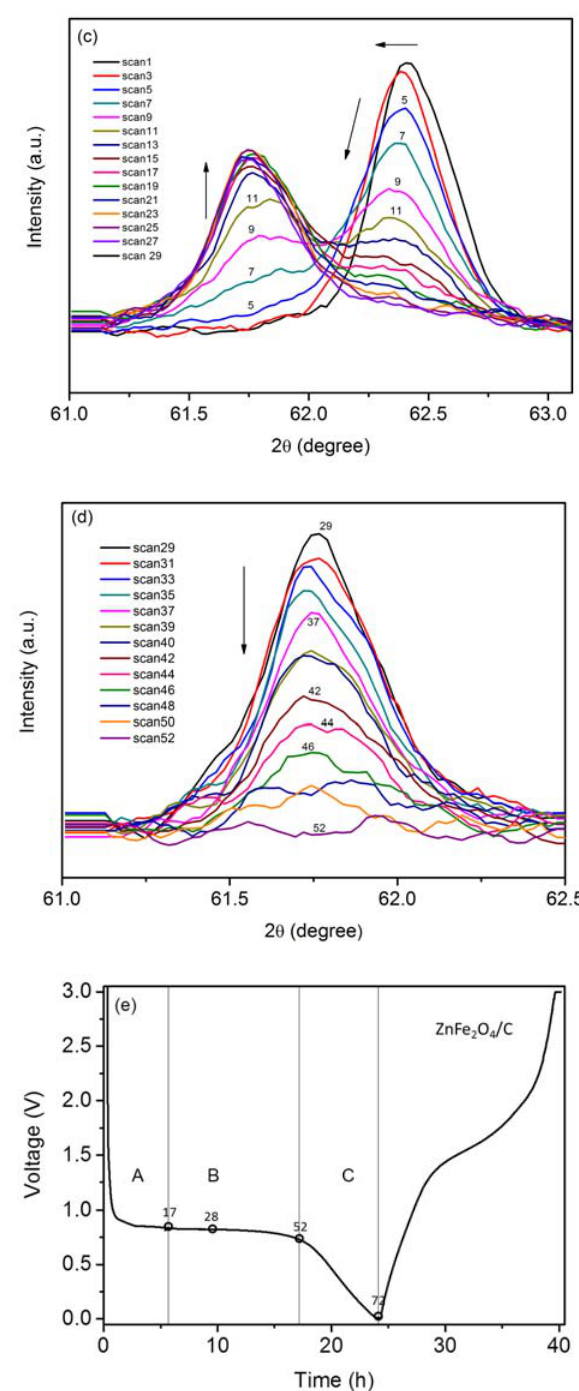
Figure 8. (a) In situ XRD study: Evolution of the XRD patterns upon the first lithiation process (scan 1 to 72). The scans refer to the different sections marked in panel e are indicated by different colors: (A) black, (B) red & green and (C) blue. The 2 θ ranges from 25 to 45 and 55 to 70, within which the reflections of the Be window are not shown. De- tails on the evolution of the XRD patterns: b) Scans 1 to 3; c) Scans 1 to 29; d) Scans 29 to 52 (only every cycle second cycle is shown) upon lithiation in a 2 θ range of 61° to 63°. (e) Representative voltage vs. specific capacity profile of the constant current discharge/charge cy- cling of the ZnFe O /C anode at 0.05C (1 st cycle) belonging to the in 2 4 situ XRD measurement and displaying corresponding XRD